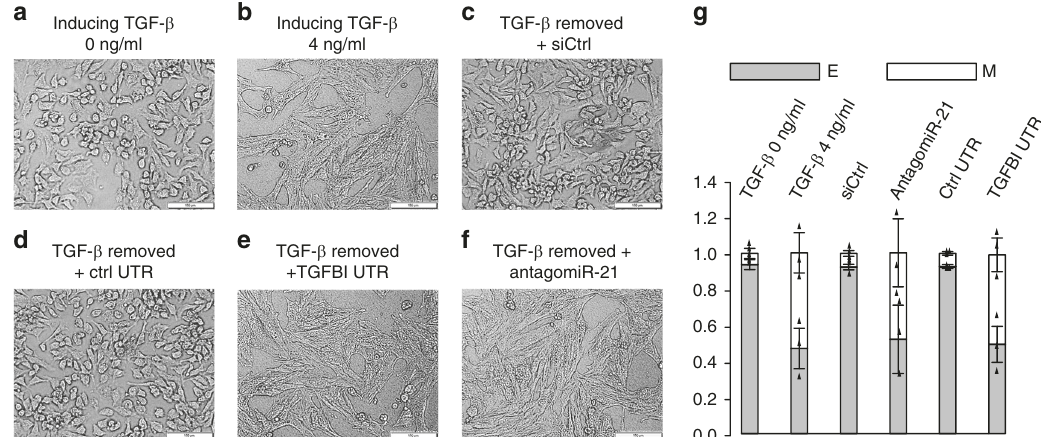
Fig. 6 CeRNA abundance determines EMT reversibility in A549 cells. a Morphologies of untreated A549 cells. b Morphologies of A549 cells treated with 4 ng/ml of TGF- β for 7 days to induce EMT. c Morphologies of cells treated by 4 ng/ml TGF- β for 7 days followed by TGF- β removal and treated with control siRNA for 3 days. d Morphologies of cells treated by 4 ng/ml TGF- β for 7 days followed by TGF- β removal and treated with control UTR for 3 days. e Morphologies of cells treated by 4 ng/ml TGF- β for 7 days followed by TGF- β removal and treated with TGFBI UTR for 3 days. f Morphologies of cells treated by 4 ng/ml TGF- β for 7 days followed by TGF- β removal and treated with antagomiR-21 for 3 days. g Cells in ( a – f ) were subjected to fl ow cytometry analysis by double staining with CDH1 and VIM antibodies and quanti fi ed into E (epithelial cells, gray bars) and M (mesenchymal cells, white bars). The images in ( a – f ) are representative of three independent biological replicates. Scale bars: 100 μ m. n = 3; error bars indicate the means ±